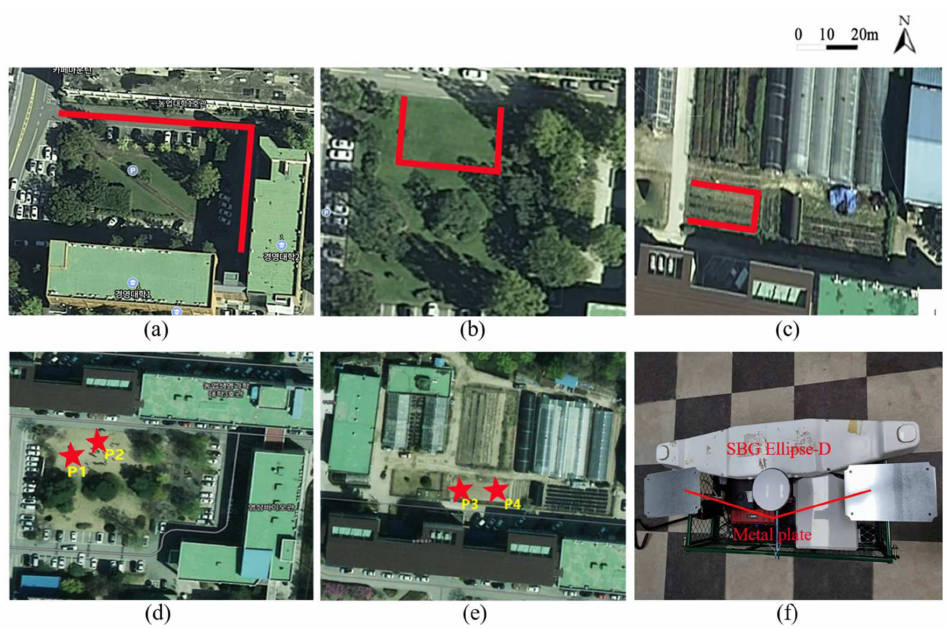
Figure 5. Experiment environment and path. ( a ) Experiment path on a road (length = 96 m). ( b ) Experiment path on grass (length = 60 m). ( c ) Experiment path in a field (length = 44 m). ( d ) Static experiments of P1 and P2. ( e ) Static experiments of P3 and P4. ( f ) SBG Ellipse-D and metal plates used in the